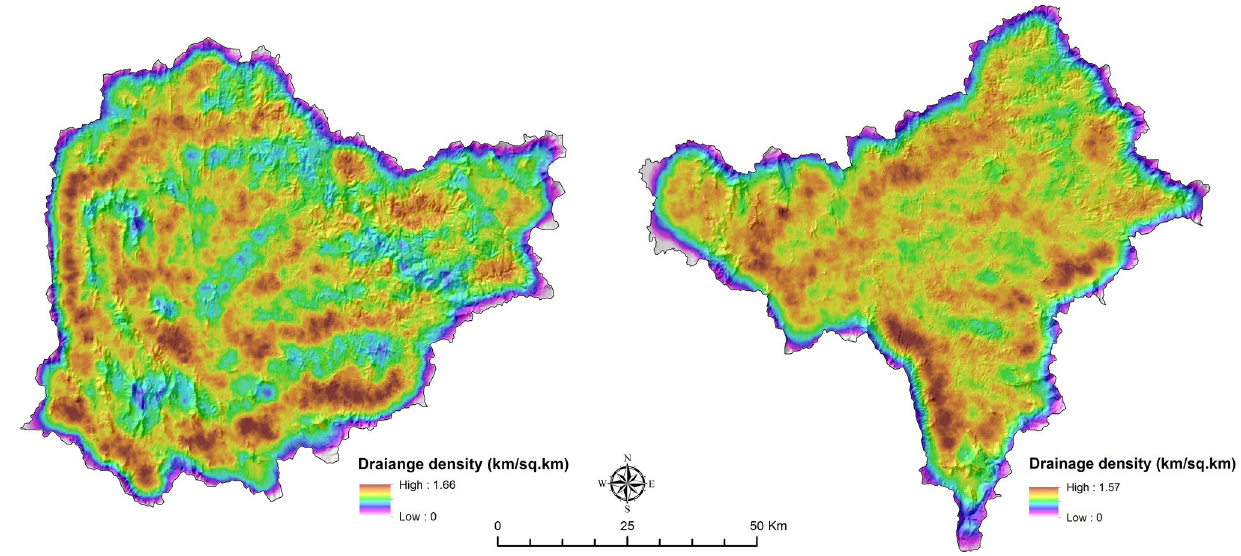
Fig. 5 Drainage density map of Vaitarna and Ulhas